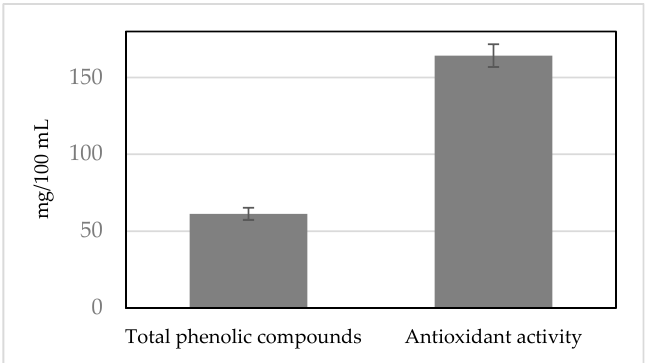
Figure 1. Content of total phenolic compounds (mg GAE/100 mL) and antioxidant activity (mg TE/100 mL) in SOFB.